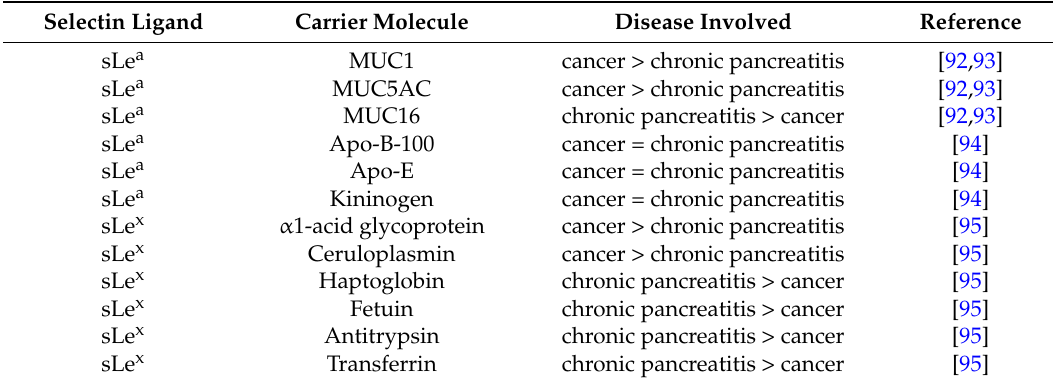
Table 1. Plasma protein-carrying sialyl-Lewis (sLe) antigens in pancreatic diseases. sLe a : sialyl-Lewis a; sLe x : sialyl-Lewis